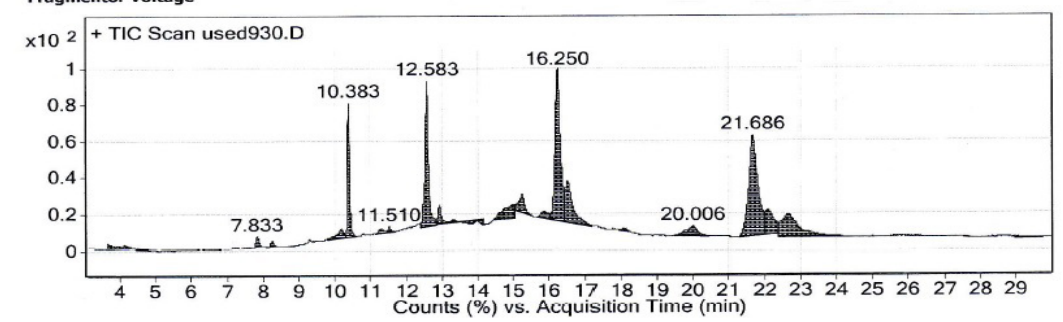
Figure 6: The chromatograms of used cooking oil before transesterification.